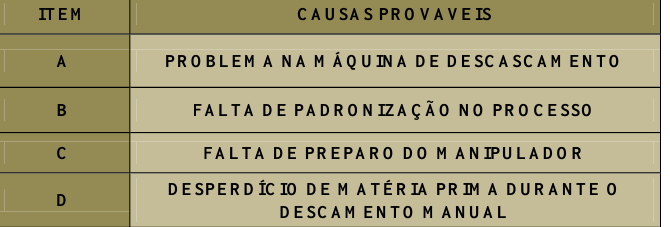
Fonte: Autores, (2017).